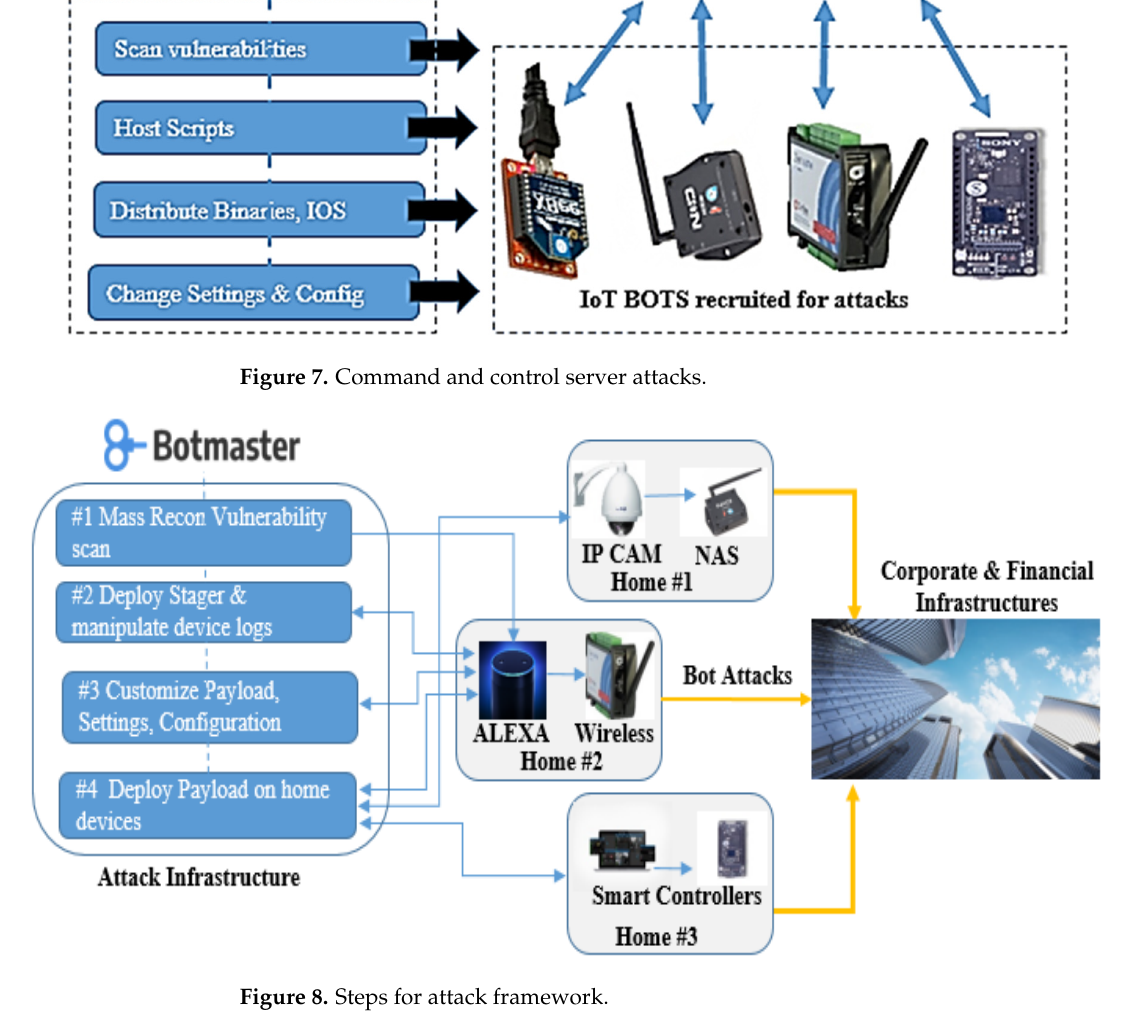
Figure 8. Steps for attack framework.